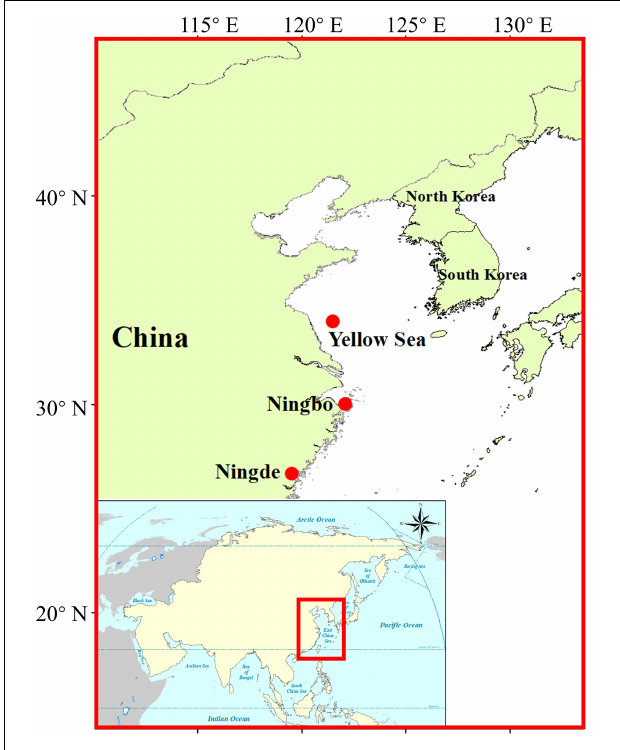
FIGURE 1 | The sampling locations of large yellow croaker in